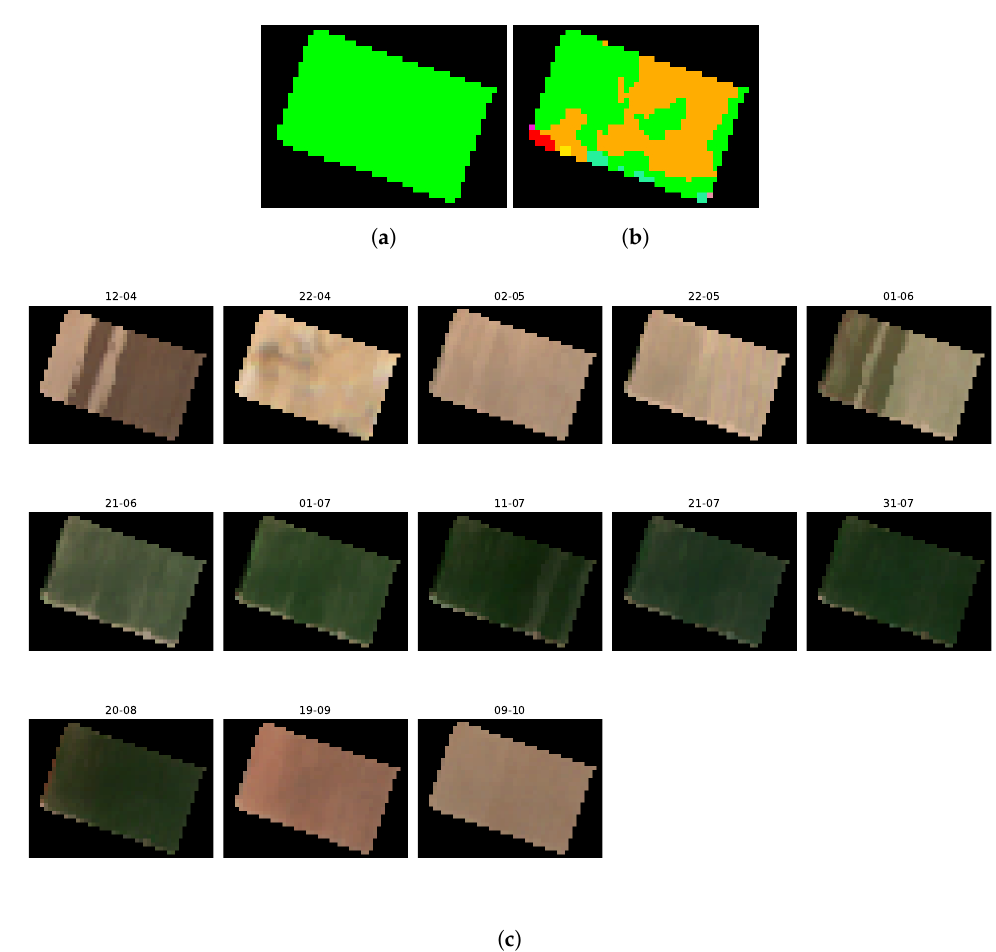
Figure 19. Comparison between the ground truth and candidate classes image of the second mis-split field, alongside multitemporal Sentinel-2 imagery of the parcel. ( a ) Ground truth class image of the mis-split field n°3. ( b ) Candidate classes image of the mis-split field n°3. ( c ) Sentinel-2 imagery of the third detected mis-split